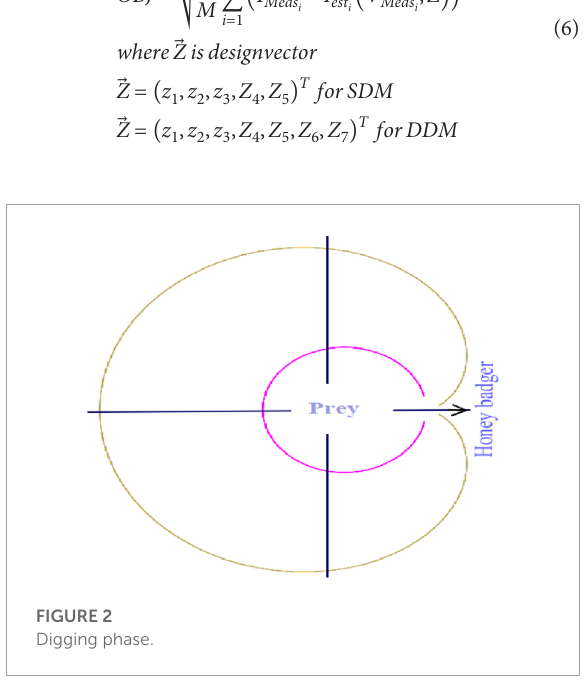
FIGURE 2 Digging